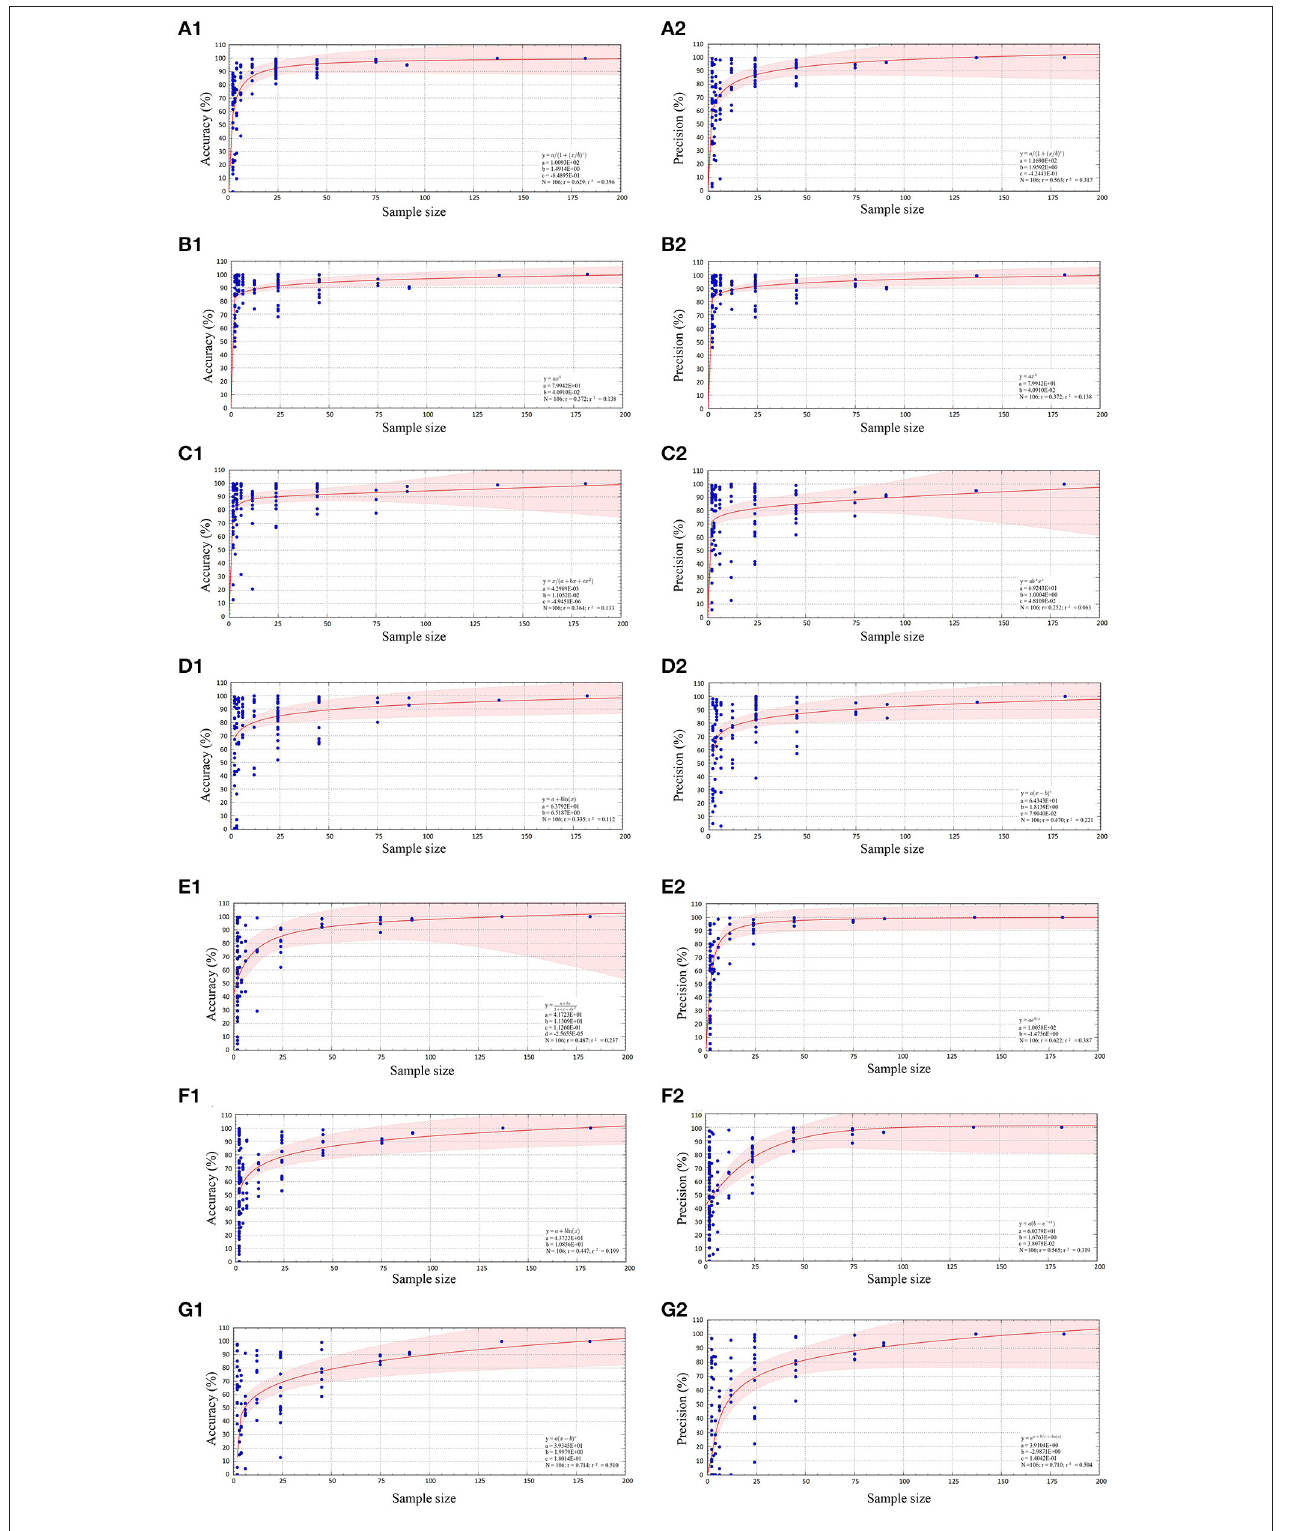
FIGURE 3 | Trends in the accuracy (1) and the precision (2) of the amount of meat of (A) Pecari tajacu , (B) Cuniculus paca , (C) Tayassu pecari , (D) Mazama sp. (E) Hydrochoerus hydrochoeris , (F) Tapirus terrestris , and (G) Lagothrix sp. (in fresh converted kilograms) in relation to the results obtained with the maximum sampling effort in two 12-month surveys conducted in 2006–2007 and 2017–2018.